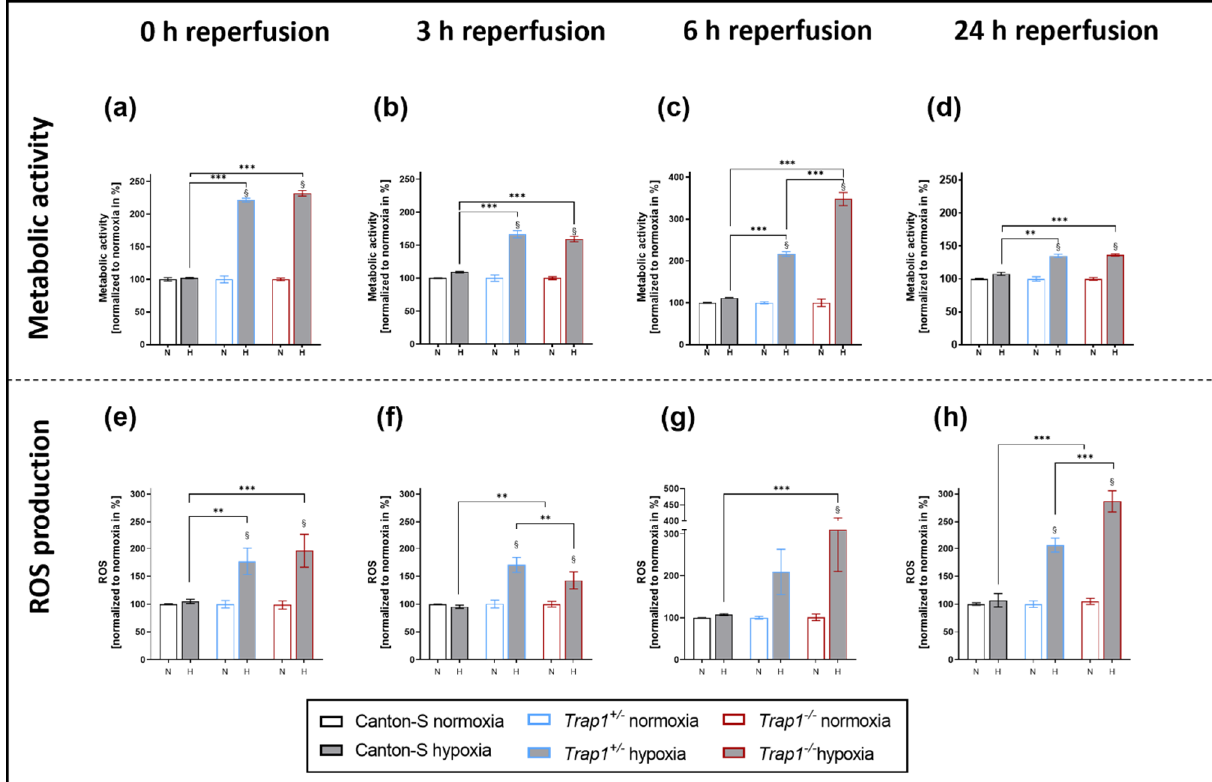
Figure 3. Metabolic activity and ROS production of Canton-S, Trap1 +/ − and Trap1 − / − flies during a reperfusion period of 24 h. ( a–d ) Metabolic activity in the supernatant in fly head lysates after 3 h of hypoxia. ROS production in the fly head lysates is shown in ( e–h ) . The graphs present the means ± SEM of 4 independent experiments. Two-way ANOVA followed by Tukey post-hoc. ** p < 0.01, *** p < 0.001. § p < 0.05 indicates significance compared to corresponding normoxia.